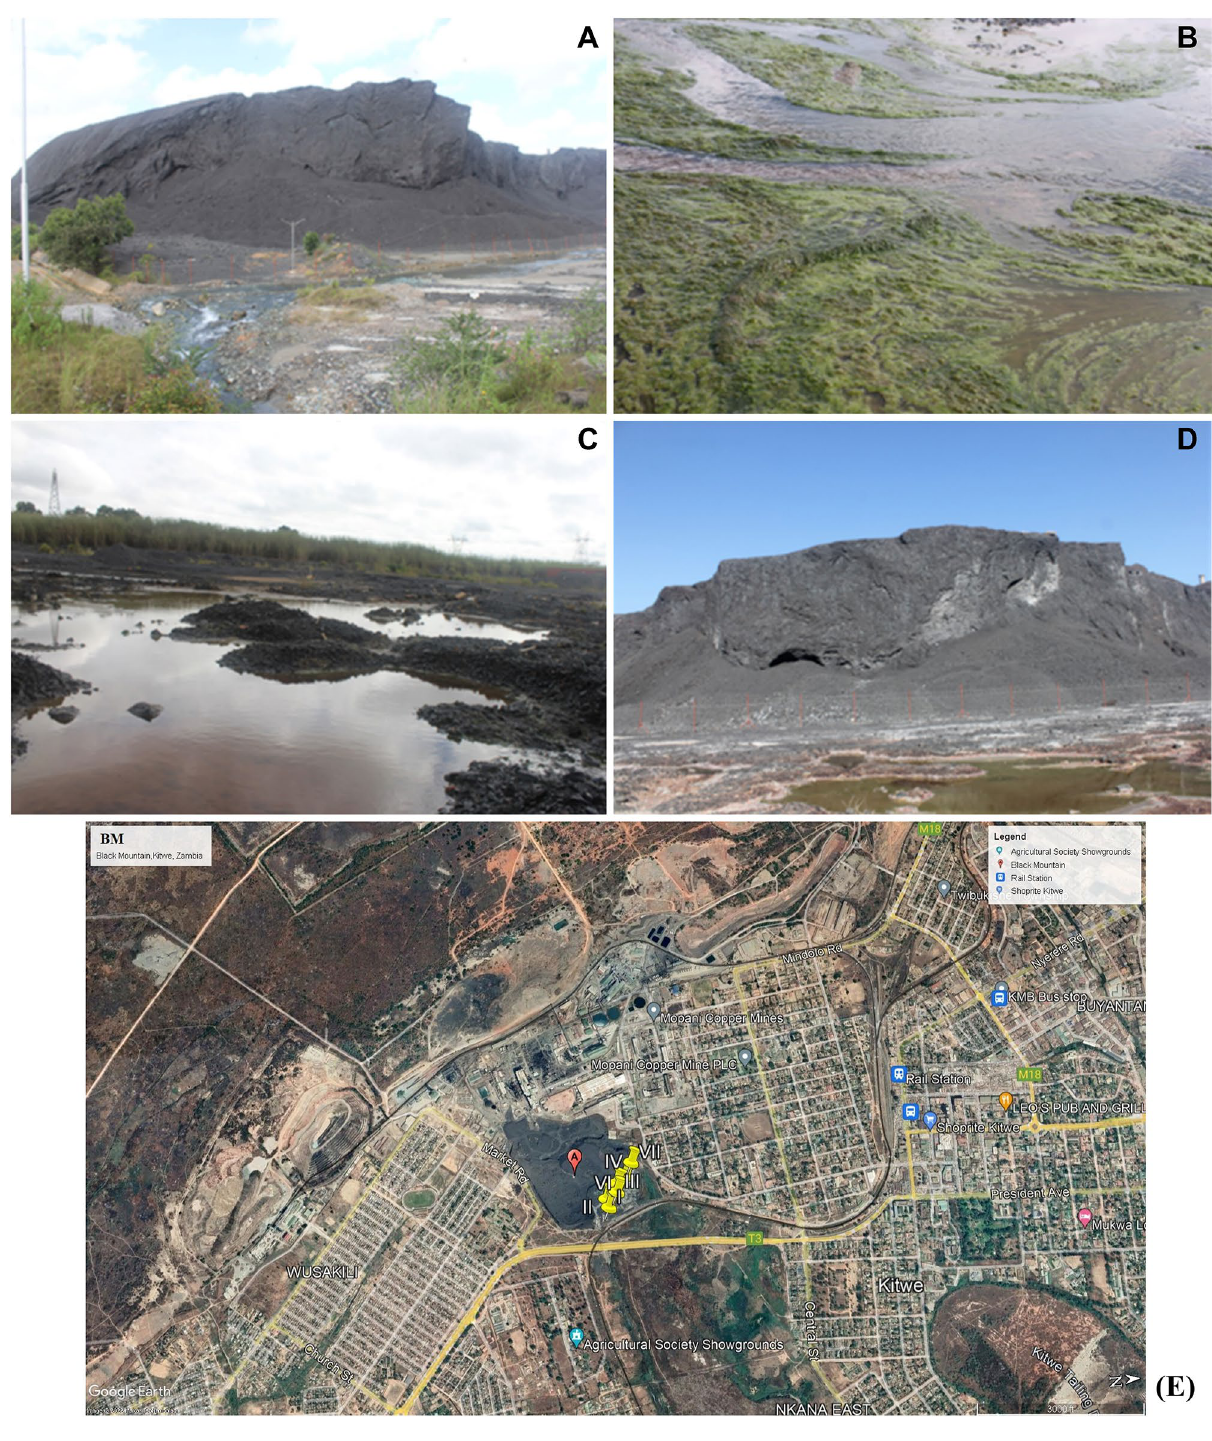
Figure 2. An overview of Nkana slag dumpsites in Kitwe. ( A ) River borders the Nkana Slag Dumpsite. Therefore, the erosion due to rain and wind might contaminate the water flowing from the river. ( B ) The algae colonization of the wastewater closer to the Black Mountain. ( C , D ) the wastewater, stagnant grasses, and trees surviving in the leftovers of the slag dump. Images: Leonce, June 2021. ( E ) An aerial photograph showing sampling points in yellow numbered I to VII at Nkana tailing dam location (BM) and surrounding area, Google Earth Satellite Image system, January